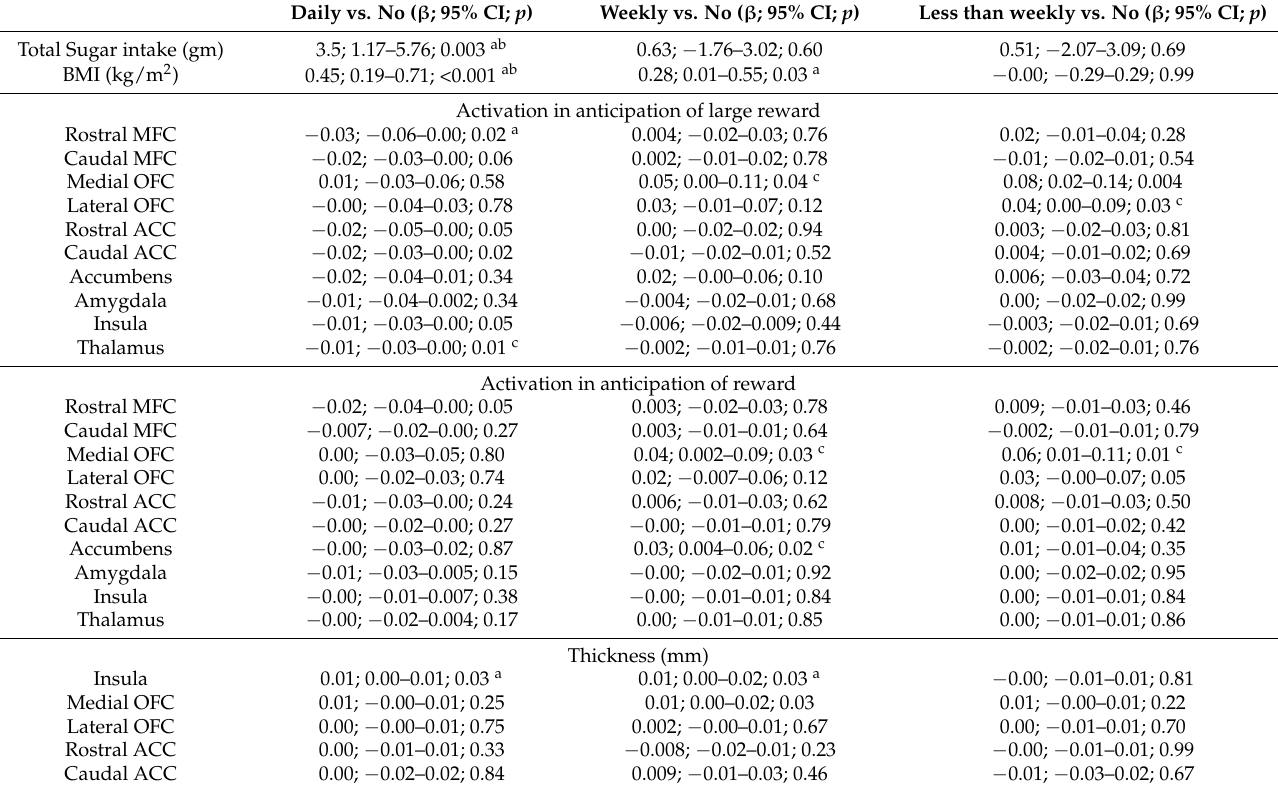
Table 2. Associations between prenatal caffeine exposure, total sugar intake, brain activation to reward anticipation, thickness measurements of taste-processing